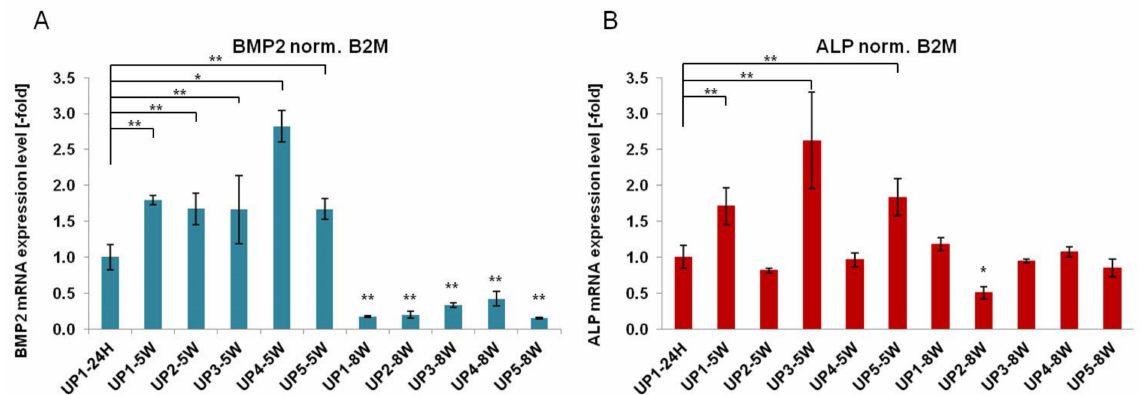
Figure 9. Gene expression of hADMSCs seeded in UP scaffolds. RT-PCR analysis of ( A ) bone morphogenetic protein-2 (BMP2) and ( B ) alkaline phosphatase (ALP) expression following culture in UP scaffolds for 5 and 8 weeks ( n = 3). Asterisks indicate statistically significant differences compared to the control cultures at each time point (* p < 0.05, ** p <